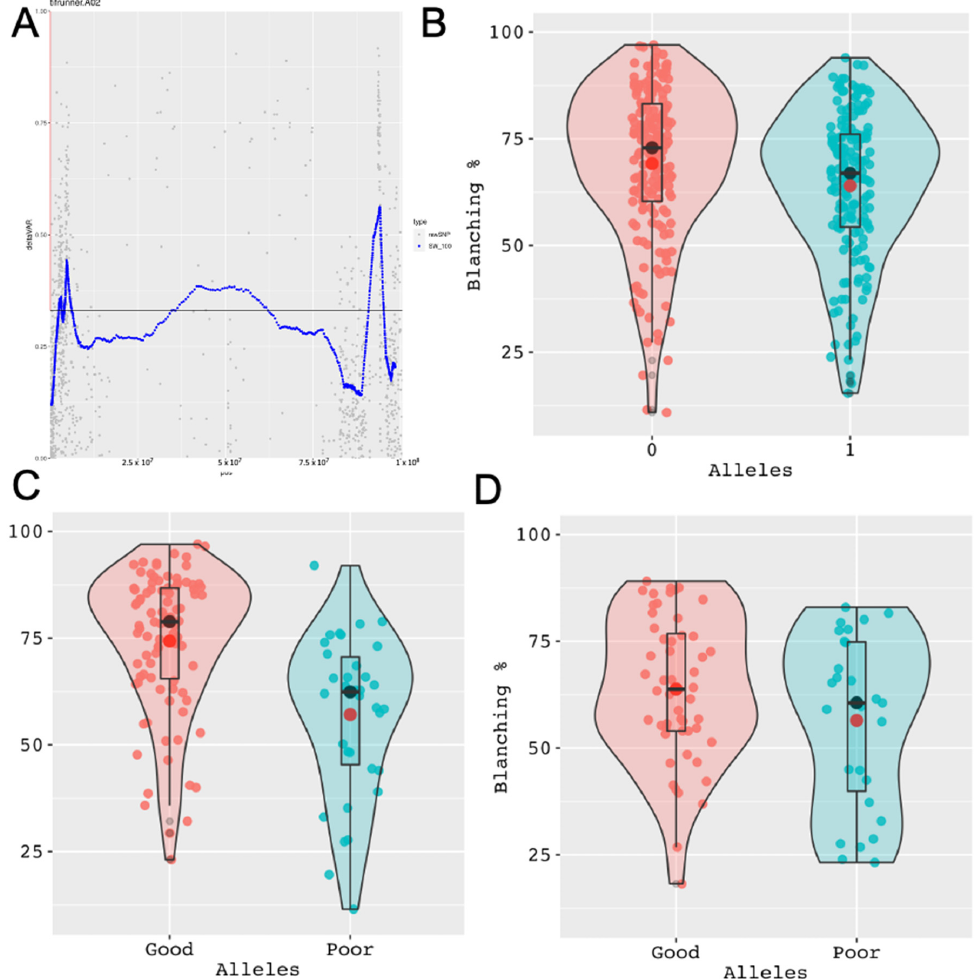
Figure 2. Effect of wild introgressions on blanchability. ( A ) QTL-seq shows signal corresponding to two A. cardenasii introgressions on chromosome A02. Note, there is a gap of SNPs in the introgression on the top of the chromosome due to those reads being filtered out. The signal shows A. hypogaea alleles in strong linkage with the introgression. ( B ) Selecting for the introgressions negatively affects blanchability. 0— hypogaea allele; 1— cardenasii allele. ( C ) When selecting against the introgressions, the QTLs on A06 and B11 can select for increased blanchability. ( D ) When selecting for the introgressions, the QTLs on A06 and B11 have little to no effect on blanchability.